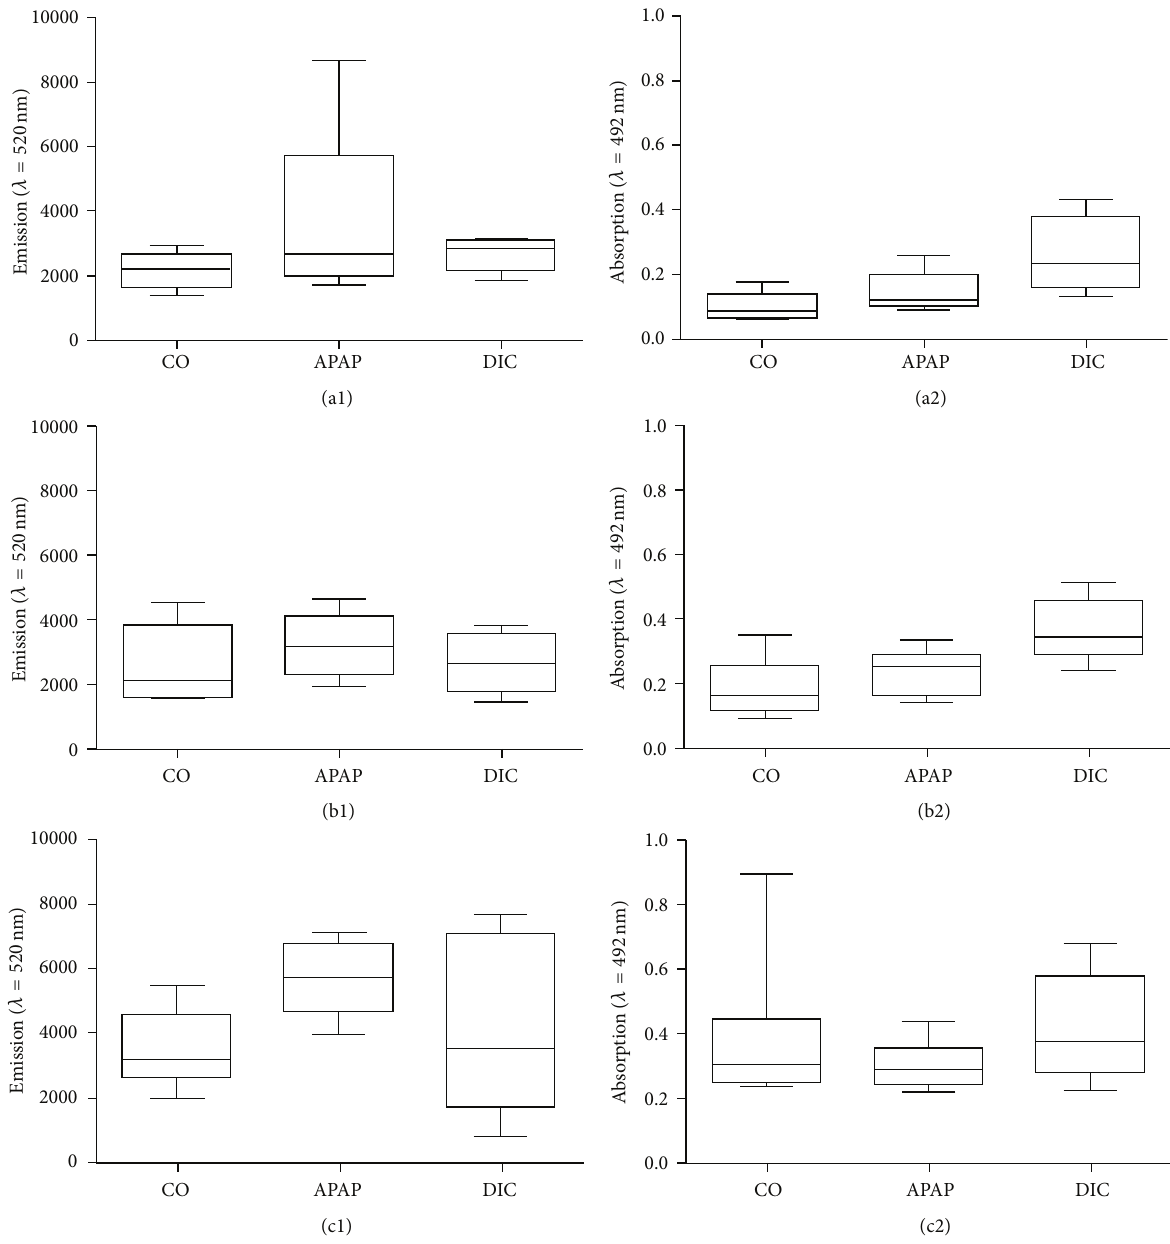
Figure 4: Induction of oxidative stress in PHH . PHH from three individual donors (A, B, and C, see Table 1) were treated with 100 𝜇 M acetaminophen (APAP) or 100 𝜇 M diclofenac (DIC) for 1 h. Intracellular ROI formation ((a1), (b1), and (c1)) was investigated by the DCF assay and the cell activity ((a2), (b2), and (c2)) was determined by the XTT assay. Data are shown as box plots, representing the median, the interquartile range, and minimum and maximum values, 𝑛 = 4